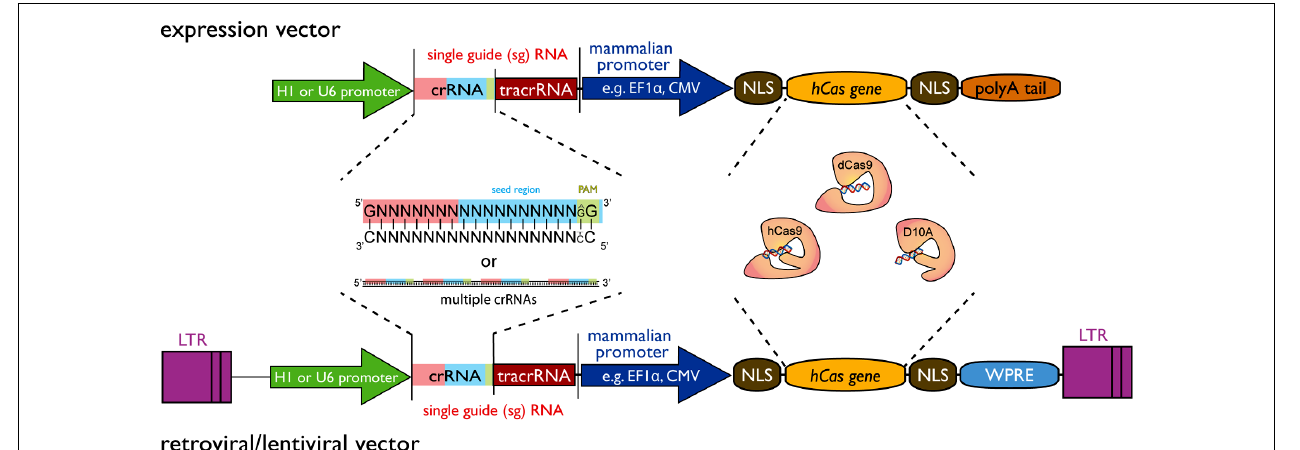
FIGURE 1 | Design principle of a CRISPR/Cas9 expression vector for construction of large-scale libraries. The vector requires two minimal components, i.e., the single-guide RNA (sgRNA) sequence and the Cas9 gene that can both be expressed from a single-vector system.The sgRNA is composed of a variable crRNA and a constant tracrRNA.The gene sequence can be inserted by a simple adaptor cloning step in the 20 bp crRNA region. Furthermore, multiple target sequences of the same gene can be inserted to increase efficiency and reduce off-target effects. At the 3 (cid:2) -end of the crRNA sequence, a 2 bp (base pair) protospacer adjacent motif (PAM – green box) of the sequence GG is essential, but AG may be used to a lesser extend as well. A 12 bp seed region (blue box) at the 3 (cid:2) -end is required for sequence tar- geting with additional 8 bp at the 5 (cid:2) -end contributing to specificity (red box). sgRNA expression can be driven by a U6 promoter or alternatively by a H1